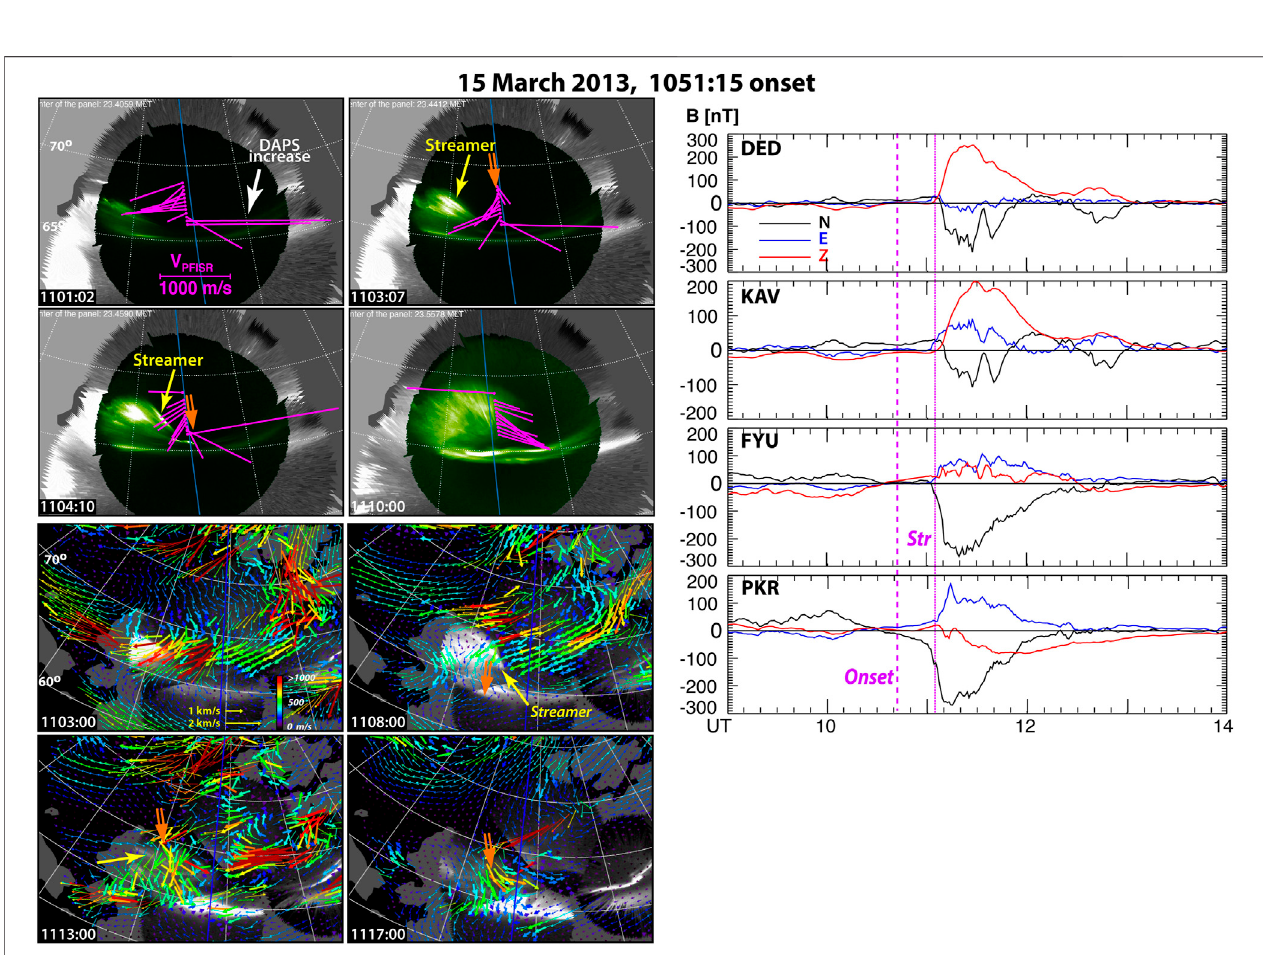
FIGURE 9 | Observations on March 15, 2013 during a period when PFISR was operating, and there were suf fi cient SuperDARN echoes available in regions of interest to provide some two-dimensional fl ow coverage. Format is the same as Figure 7 .